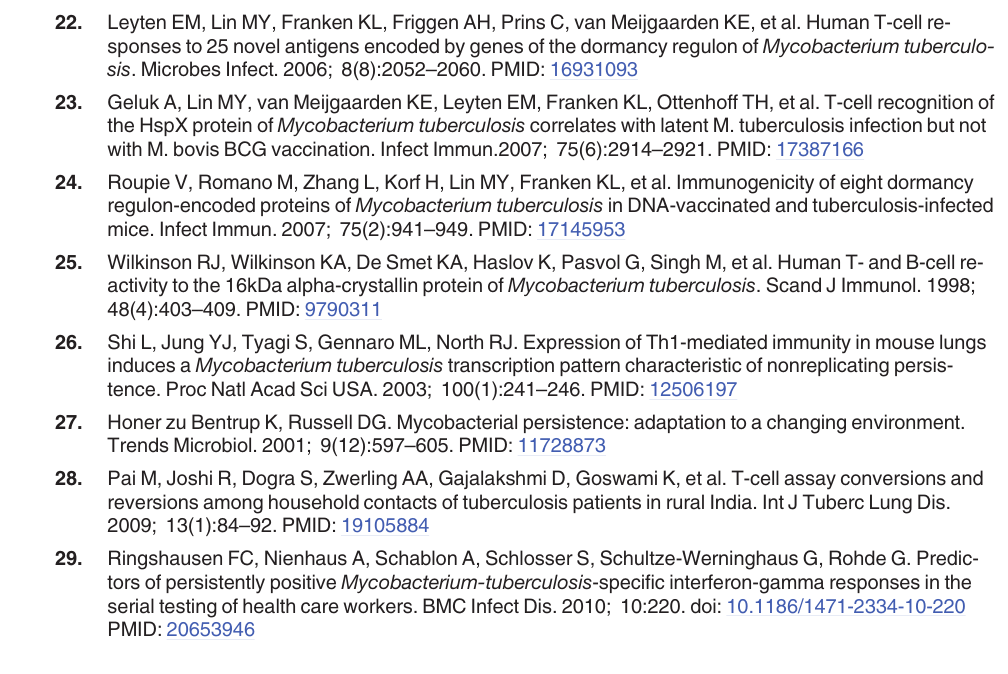
PLOS ONE | DOI:10.1371/journal.pone.0124134 April 21,